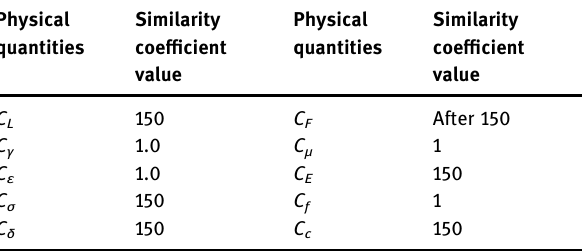
Table 2: Similarity coe ffi cient of geomechanical model test